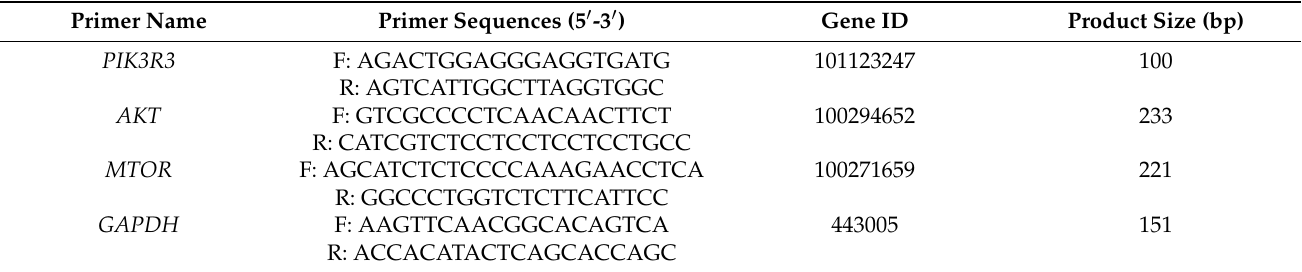
Table 1. The sequence of primers used in the study for mRNA quantitative real-time